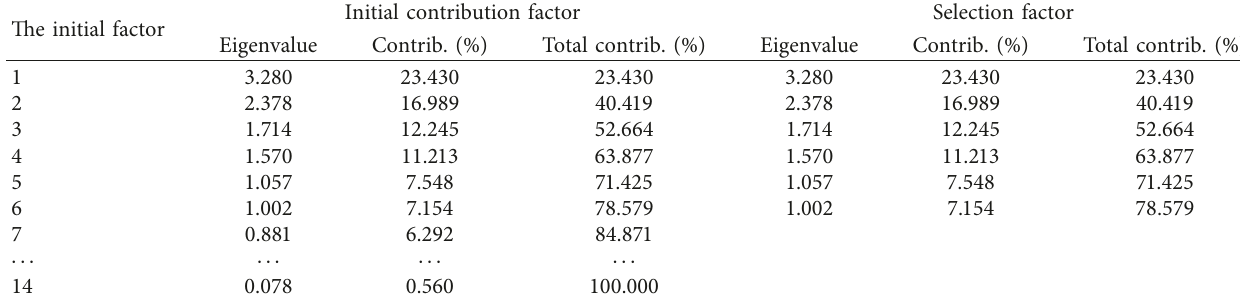
Table 4: Main components of the characteristic value and variance contribution.